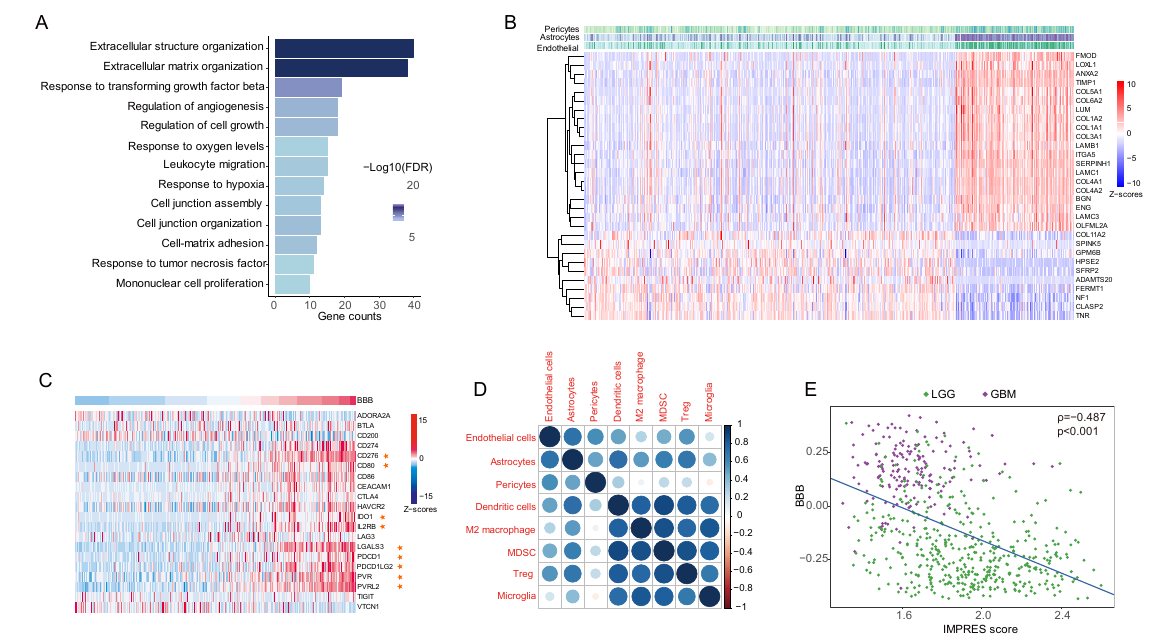
Figure 5. Tumors with higher BBB scores exhibit reorganization of the extracellular matrix and deficiency of the tumor immune response. ( A ), ECM (extracellular matrix)-relevant processes were the main biological function implicated among genes that were positively correlated with BBB score. ( B ), The top 20 and top 10 genes most positively and negatively correlated with BBB score. ( C ), The relationships between BBB score and coinhibitory immune checkpoint genes. ( D ), Dot plot showing the correlation coefficient matrix of BBB constituent cells and selected immune cell GSVA scores. ( E ), Scatter plot indicating that higher BBB scores indicate lower IMPRES values in TCGA glioma patients.